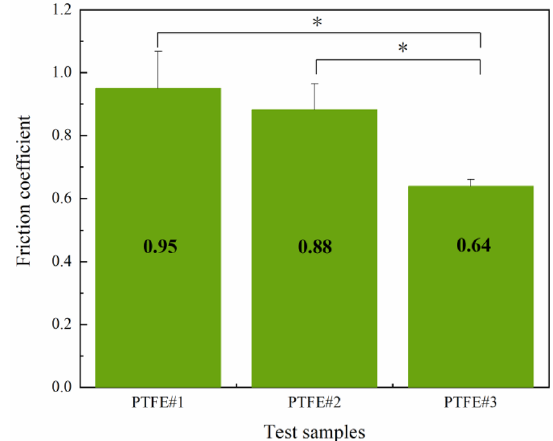
Figure 10 Friction coefficient measured for three PTFE samples. Each test was performed three times, the error bars indicate the standard deviation. The “*” indicates a significant difference (p < 0.05) between two results